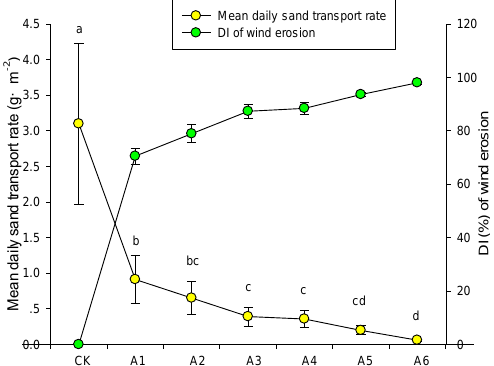
Figure 7. Variations in mean daily sand transport rate and the declining index (DI) of wind erosion. Means with different letters indicate significant differences at p < 0.05. Vertical bars represent ± standard deviation.